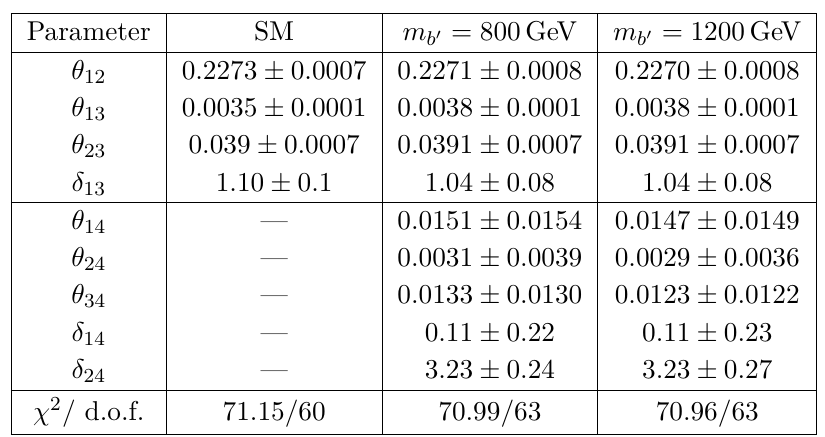
Table 3 . Best fit parameters for the quark mixing matrix with a vector-like quark isosinglet b 0 included. These are shown for two benchmark quark masses m b 0 = 800 GeV and m b 0 = 1200 GeV outlined in table 4 of ref. [26].